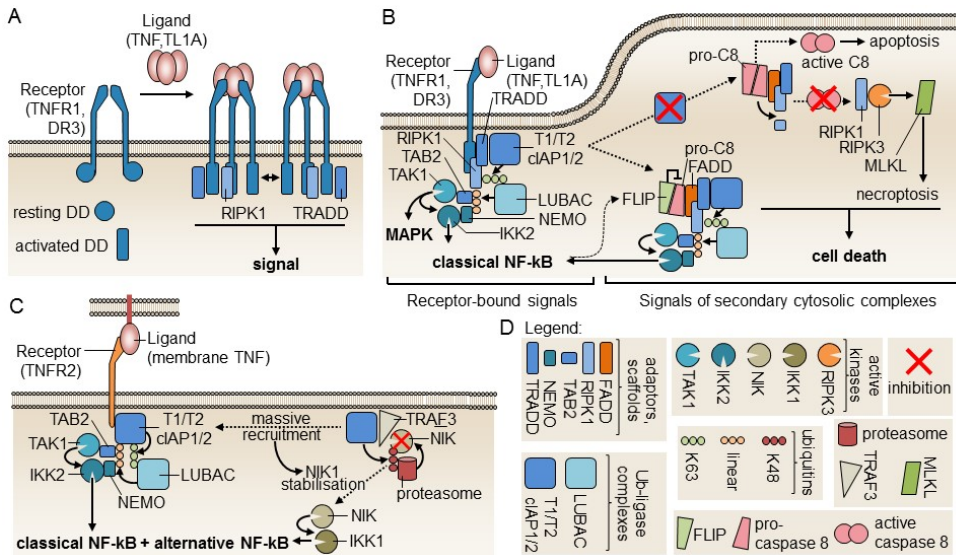
Figure 3. Models of TNFR1 and TNFR2 signaling. ( A ) Upon receptor engagement by ligands, death domains (DDs) in TNFR1 and DR3 may switch from a resting to an activated form that are structurally distinct. Self-interaction of activated DD raises the possibility of larger receptor complexes formation (bi-directional arrow) that would explain responsiveness to soluble ligands. DD-containing proteins TRADD and RIPK1 are also recruited to activated DD. Model based on Yin et al. 2019 [80]. (B) TNFR1 receptor-interacting signaling complex and its derived soluble signaling complexes. Successive recruitment of two ubiquitin ligases complexes to TNFR1 allows ubiquitination of RIP1 (K63-linked and linear poly-ubiquitin) to recruit TAK1 and IKK2 for the activation of MAPK and classical NF- k B. Unlike what happens in other death receptors, the adapter FADD is not recruited to TNFR1. The signaling complex must first dissociate from receptors as a cytosolic complex to bind FADD and pro- caspase-8. If pro-caspase-8 is inhibited by FLICE/Caspase 8 inhibitory protein (FLIP), cell death is not induced. If NF- k B is impaired, active caspase-8 is produced, which processes RIPK1 to an inactive form and induces apoptosis. If caspases are inhibited, RIPK1 is not cleaved and induces necroptosis via RIPK3 and MLKL. Model based on the review of Wajant and Siegmund [81]. (C) Signaling by TNFR2. TNFR2 activates classical NF- k B by a mechanism similar to that of TNFR1, except that the DD-containing proteins TRADD and RIPK1 are not implicated. As the ubiquitin ligase that targets NIK for degradation in the resting state is recruited to TNFR2 upon signaling, NIK escapes degradation and stimulates alternative NF- k B signaling via IKK1. Model based on Wajant and Siegmund [81]. (D) Graphical legend for signaling components depicted in panels A, B, and C. 5. Evidence of the Anti-Inflammatory Functions of TNF and Its Role in Tregs Function Apart from the predominant proinflammatory function of TNF, multiple sources support an anti-inflammatory role of this cytokine in chronic infections and in the chronic phase of many inflammatory diseases [83]. One of the first compelling indications of the impact of TNFR2 in Tregs biology was that TNFR2-deficient mice exhibited a reduction in Tregs cell number in both the thymus and secondary lymphoid organs [84]. This phenotype was similar to that seen in mice that are triple- knockout for the three known (human) TNFR2 ligands: TNF, lymphotoxin- α , and lymphotoxin- β [78], of which TNF might be the most relevant due to the fact that only mouse TNF binds to mouse TNFR2 [85]. Mice knock-in for human TNF, which unlike mouse TNF does not bind to mouse TNFR2, have a decreased Treg function, unless they are also knock-in for human TNFR2. Specific ablation of TNFR2 in Tregs did not decrease their numbers but diminished expression of signature genes and impaired suppressive activity in vitro, and in vivo in an experimental autoimmune encephalitis model, directly demonstrating a critical intrinsic role of TNFR2 to maintain the functionality of Treg